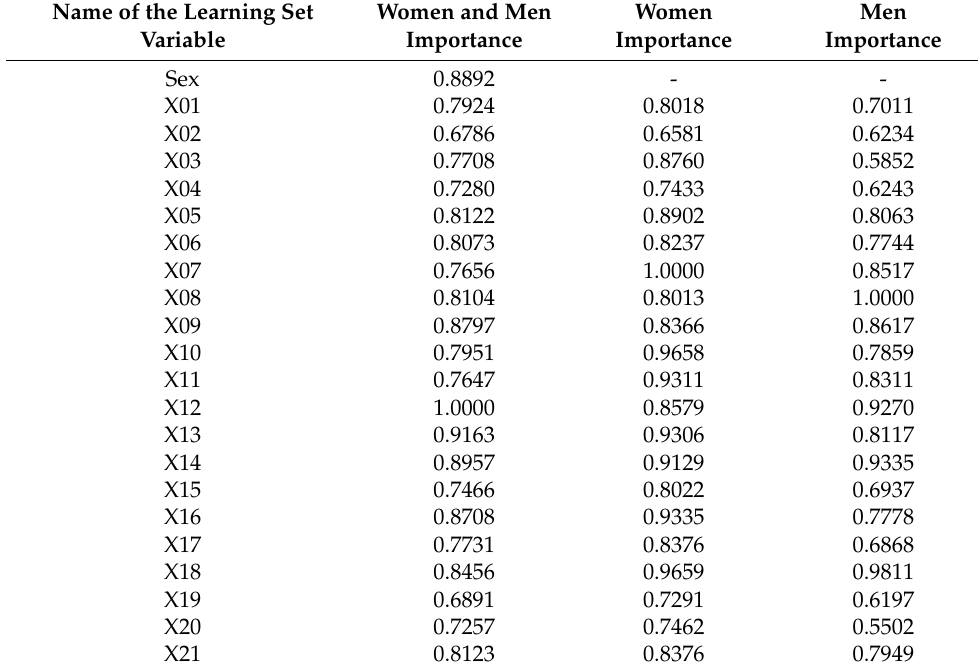
Table 10. Summary of the significance of variables for each learning set and generated